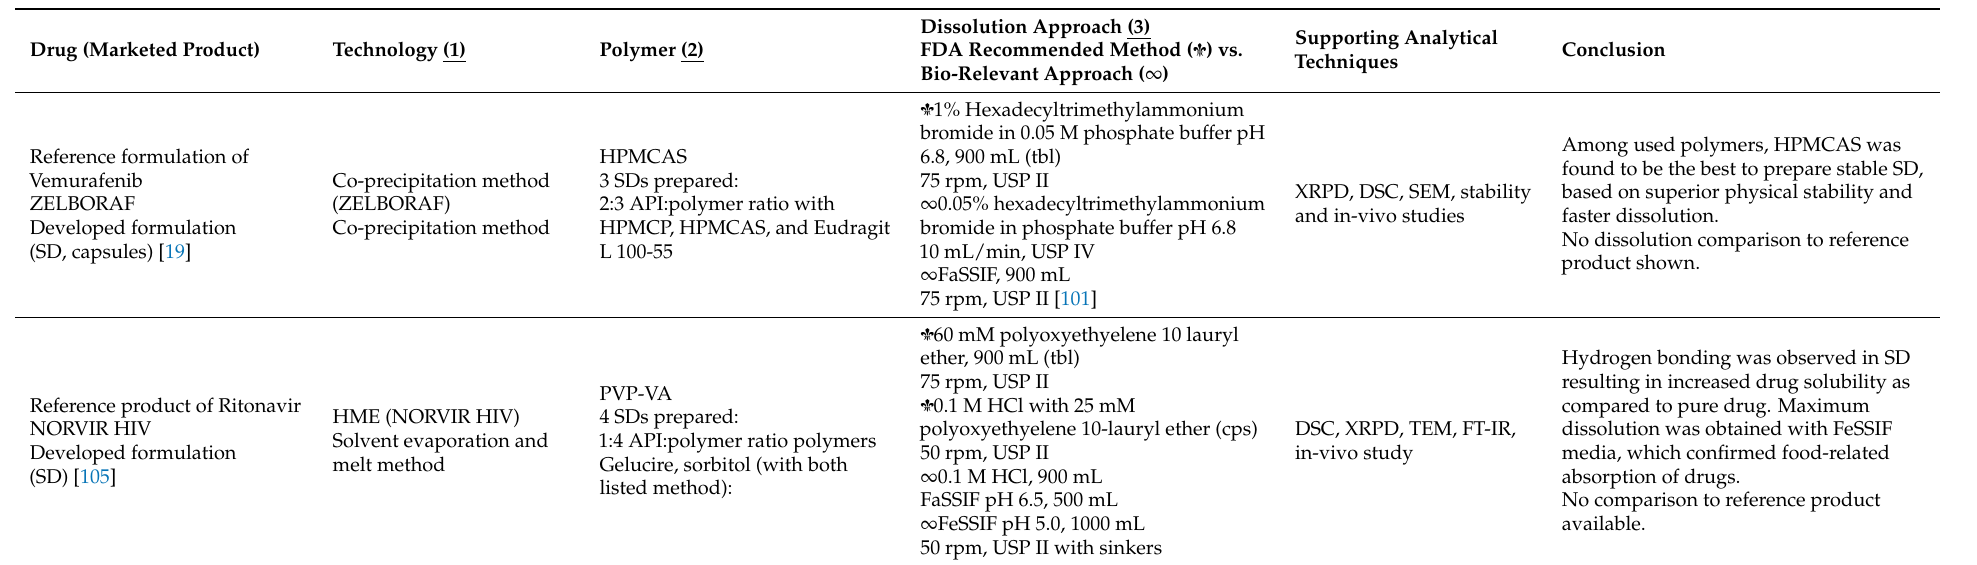
Table 2. Review of dissolution studies on amorphous solid dispersion formulations.